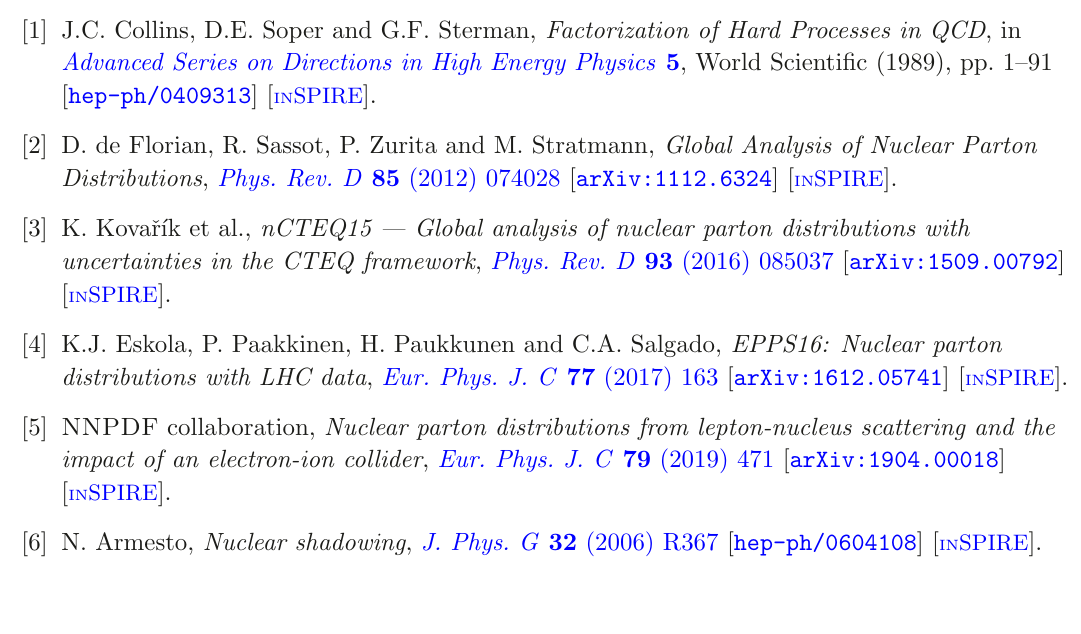
y < 0 : 8 (left), 0 : 8 < j j